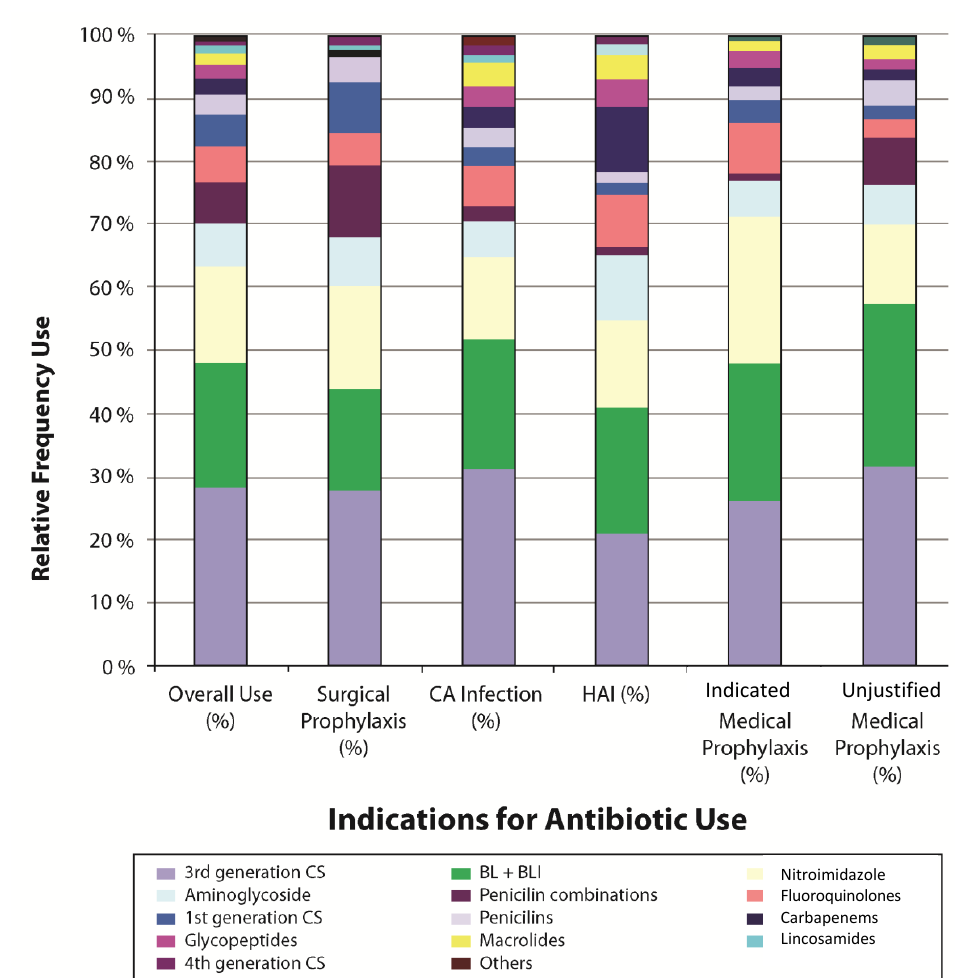
Figure 2. Frequency of use of individual antibiotic classes for prophylaxis and treatment among 3408 patients in 18 Egyptian hospitals—March 2011.